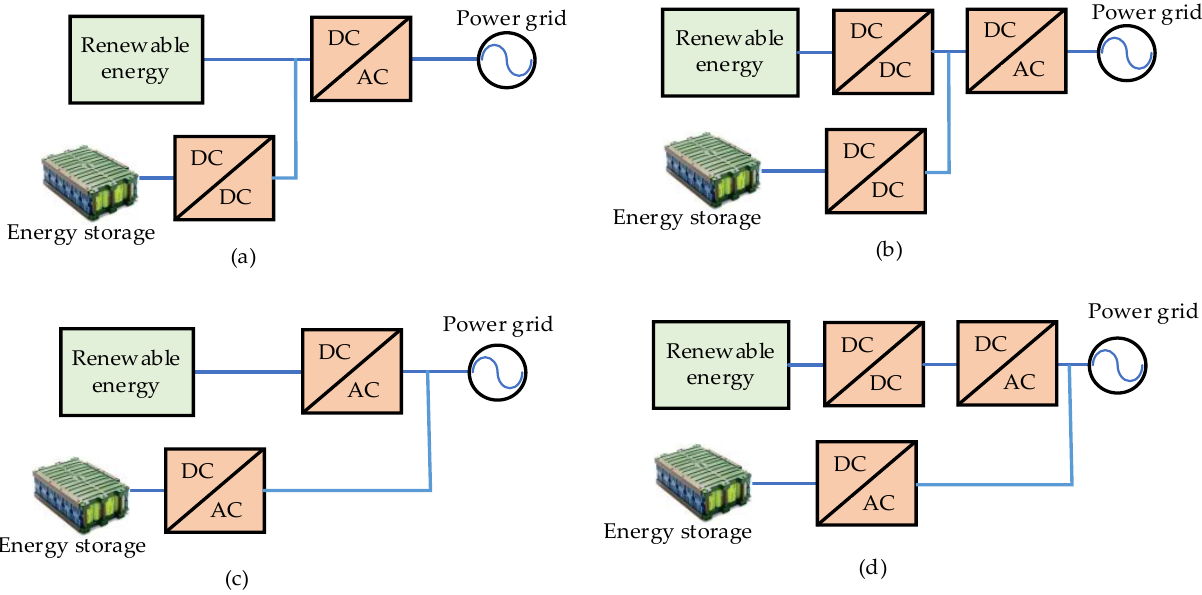
Figure 9. Energy storage VSG. ( a ) Single-stage common DC bus VSG; ( b ) Dual-stage common DC bus VSG; ( c ) Single-stage common AC bus VSG; ( d ) Dual-stage common AC bus VSG.